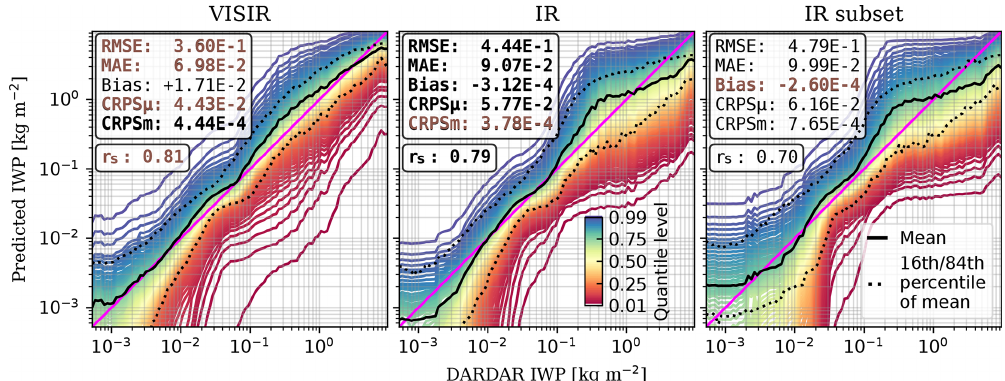
Figure 5. IWP predictions with MLP networks for the different SEVIRI channels as input (Table 2). Networks trained only with daytime observations. The solid curves indicate the median value of each prediction at the local DARDAR IWP. The statistics are computed for the expected value. In brown is the best value, and in bold font is the second best value. Summary statistics in kgm − 2 . Statistics and predictions computed using all daytime test data, with an average DARDAR IWP of 1 . 14 × 10 − 1 kgm − 2 .